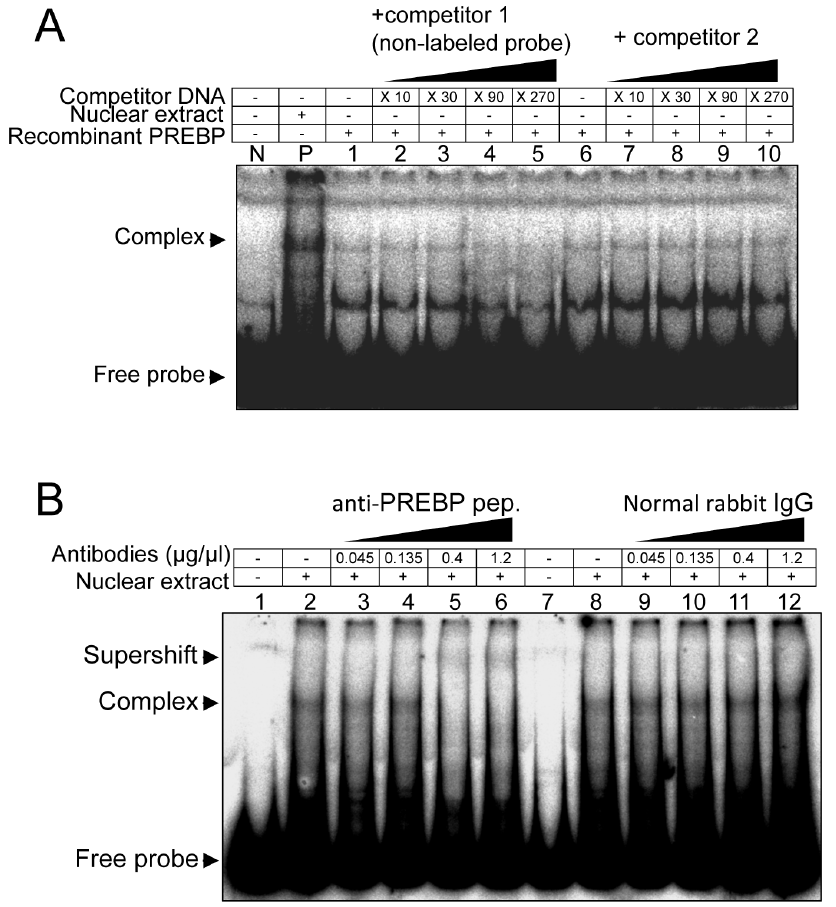
Figure 3. PF3D7_1011800 protein showed specific binding activity to the PRE sequence. (A) Cross-competition assays. EMSA was performed with the same labeled probe used in Figure 1. Lane N is probe only. Lane P is the assay with 0.6 m g of nuclear extract from the parasites at tophozoite/schizont stages. Lanes 1–10 represent EMSA with 0.1 m g of immunopurified PF3D7_1011800 fraction (see Figure 2) in the presence or absence of cross-competitors. Lanes 1–5 represent cross-competition with increasing amounts of non-labeled probe. Lanes 6–10 represent another irrelevant 62-bp sequence [16]. The amount of competitor DNA in each reaction mix was indicated at the top of the panel. (B) Super-shift assays. EMSA was performed with the same 32 P-labeled probe used in Figure 1. Lane N is probe only. Lane P and Lanes 1–10 represent EMSA with 0.6 m g of nuclear extract from the parasites at tophozoite/schizont stages in the presence or absence of antibodies. The amount of antibody added in each reaction mix is indicated at the top of the panel. Positions of the free probe, shifted band and super-shifted band are indicated on the left.